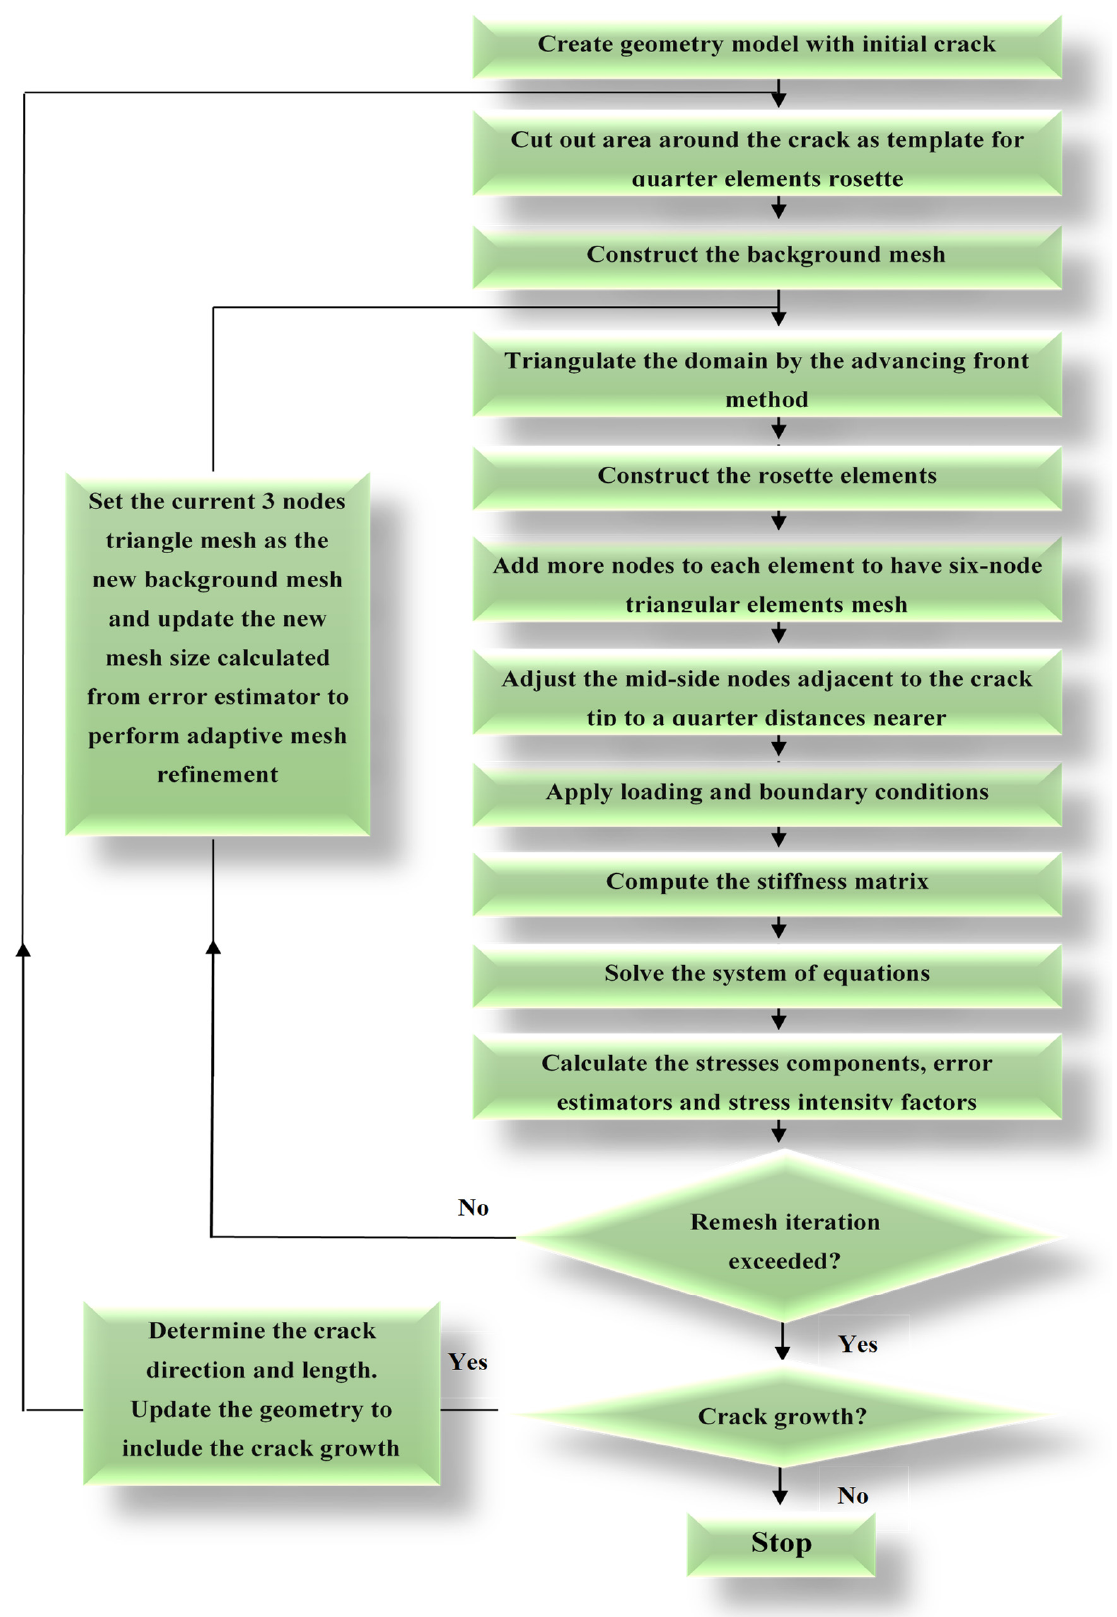
Figure 1. General flowchart of the program.